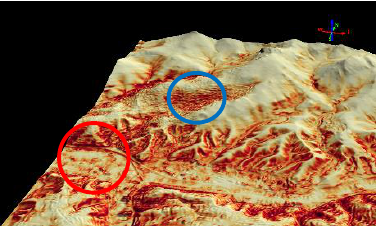
Figure 19. The DTM of the study area textured with the landslide susceptibility map (output of logistic regression).